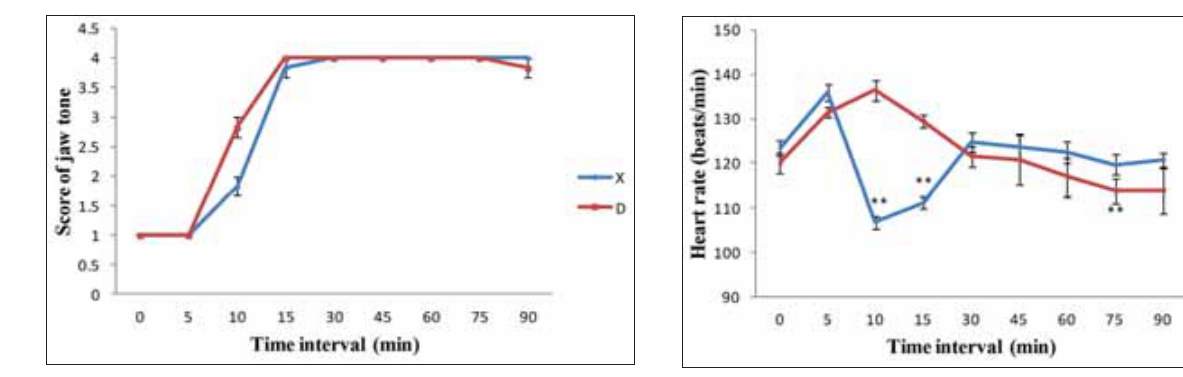
Figure-4: Mean±Standard error scores of jaw tone in animals of different groups. *Significantly different from the base value (p<0.05). **Significantly different from the base value (p<0.01).